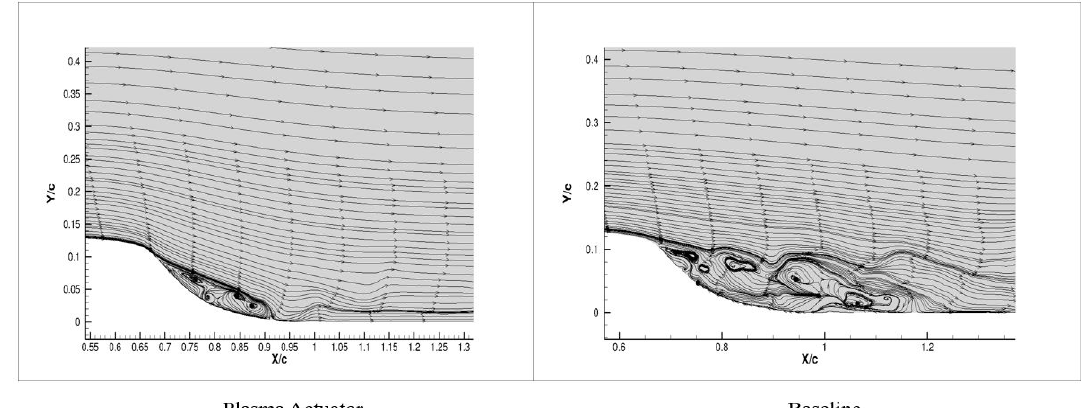
Figure 14. Velocity streamlines with the plasma